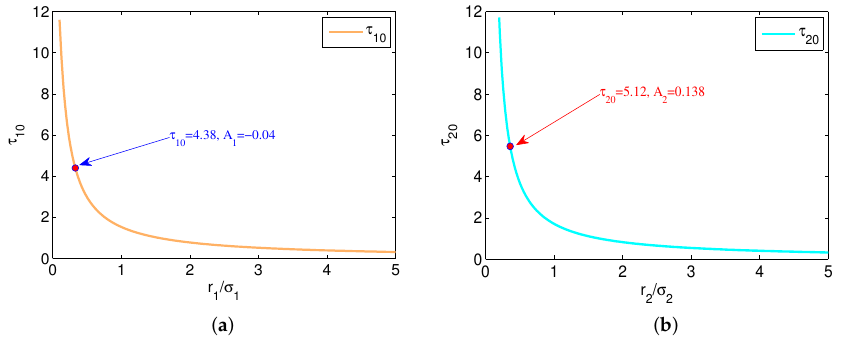
Figure 5. ( a ) The evolution between τ 10 and r 1